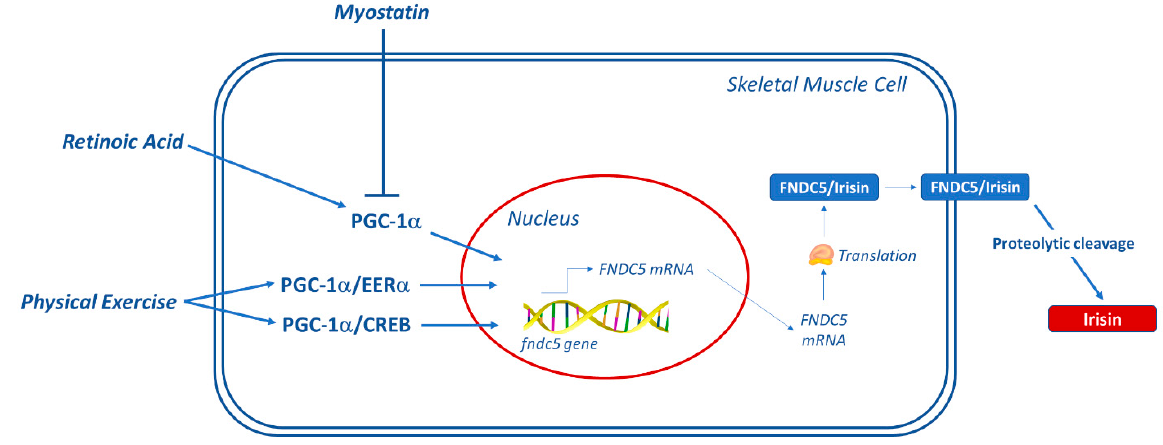
Figure 2. FNDC5/Irisin expression in Skeletal Muscle (SkM) mediated by PGC-1a. Schematic representation of irisin expression modulating factor in SkM occurring by activation or inhibition of PGC-1a. CREB: cAMP response element-binding protein; ERR α : Estrogen-related receptor α ; FNDC5: Fibronectin type III Domain Containing 5; PGC-1 α : PPAR γ coactivator 1 α .